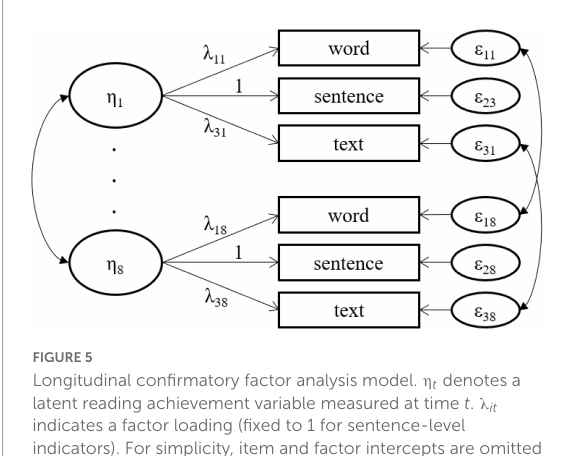
FIGURE5 Longitudinal confirmatory factor analysis model. η t denotes a latent reading achievement variable measured at time t . λ it indicates a factor loading (fixed to 1 for sentence-level indicators). For simplicity, item and factor intercepts are omitted from the path model.